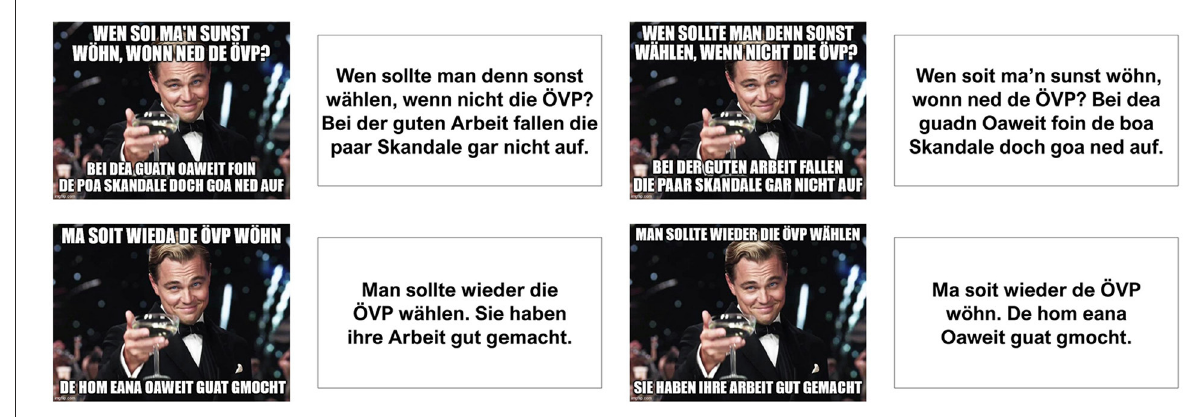
FIGURE5 Stimuli used in study II [ (top row) sarcastic messages from left to right: A1, A2, A3, A4; (bottom row) non-sarcastic messages from left to right: A5, A6, A7, A8].